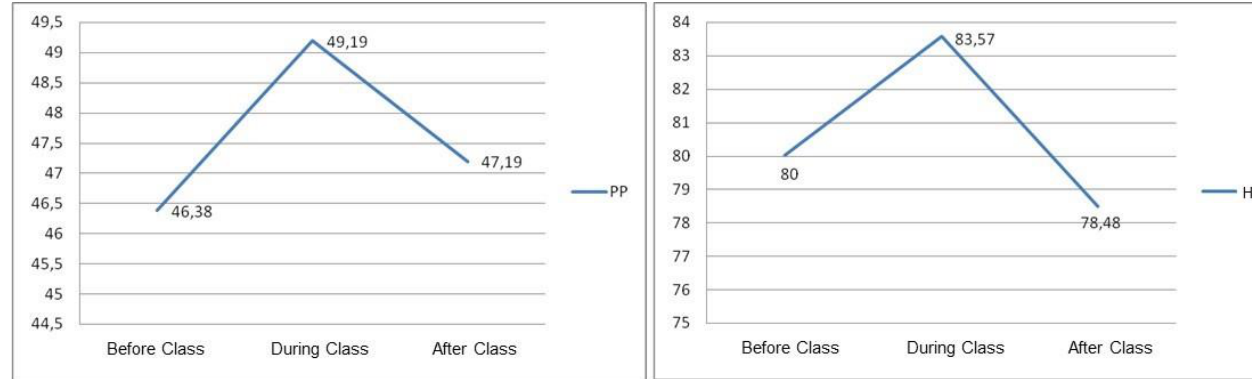
Figure 3 – PP (mmHg) and HR (bpm) before, during and after class period.